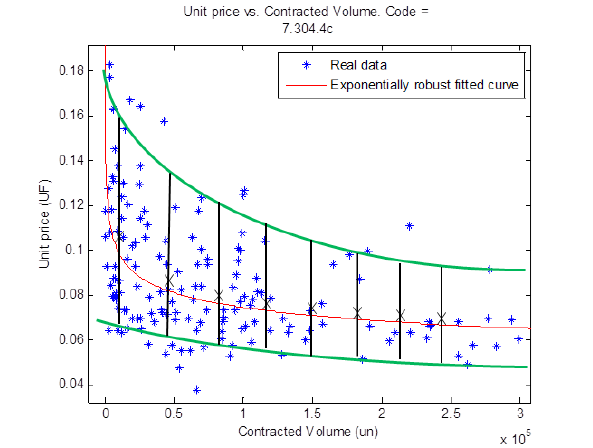
Fig. 5. Typical unit price’s